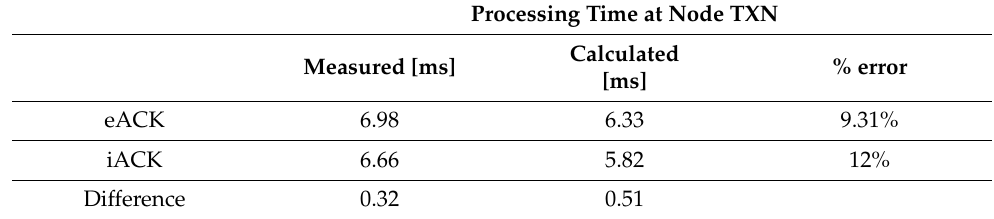
Table 7. Frame processing time (TXN